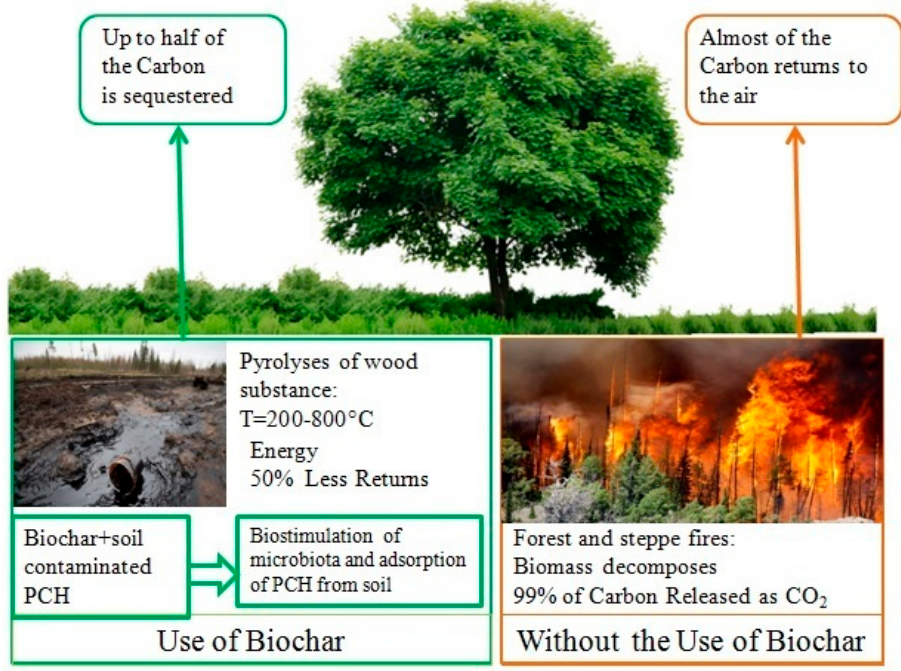
Figure 4. The difference in carbon consumption by plants in the carbon cycle: with the use of biochar and without the use of biochar. Note: PHC, petroleum hydrocarbon.